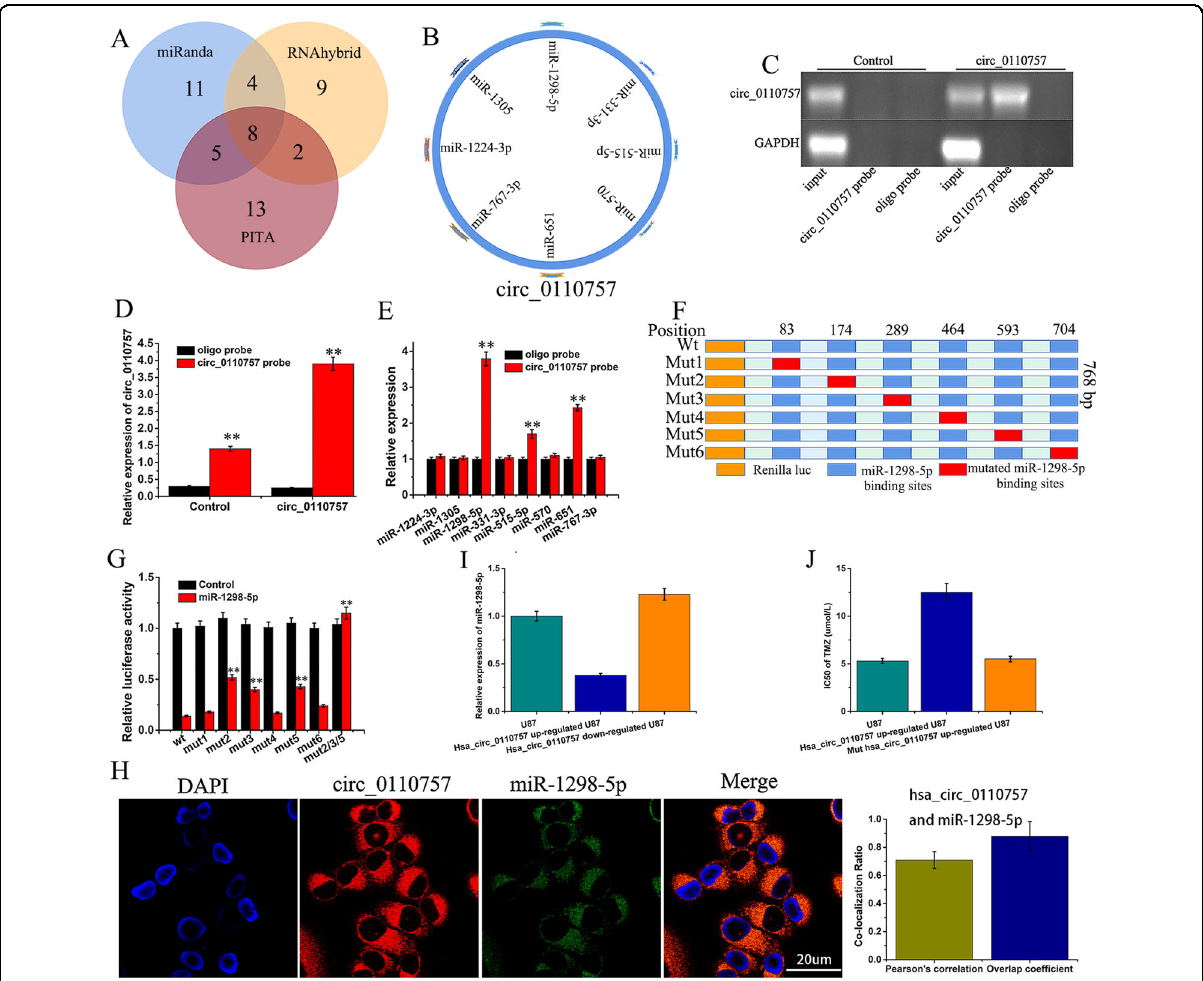
Fig. 3 Hsa_circ_0110757 works by sponging hsa-miR-1298-5p. A , B The target miRNAs of hsa_circ_0110757 were deduced by miRanda, PITA, and RNAhybrid. C , D Lysates from U87/R cells with hsa_circ_0110757 transfection were determined by PCR after RNA pull-down assay. E The expression of eight miRNAs pulled down by hsa_circ_0110757 in U87/R cells were determined by RT-qPCR. F The schematic illustration of luciferase reporters containing wild-type hsa_circ_0110757 (wt) or the hsa_circ_0110757 with mutated miR-1298-5p (mut1 – mut6) binding sites. G The luciferase activity of wt and mut1 – mut6 in U87 cells cotransfected with miR-1298-5p. H The colocalization ratio of hsa_circ_0110757 and miR-1298- 5p in U87/R cells by FISH. I The expression of miR-1298-5p in hsa_circ_0110757 overexpressed or repressed in U87 cells. J The IC50 of TMZ in wild and mutated hsa_circ_0110757 transfected U87 cells. ** P <